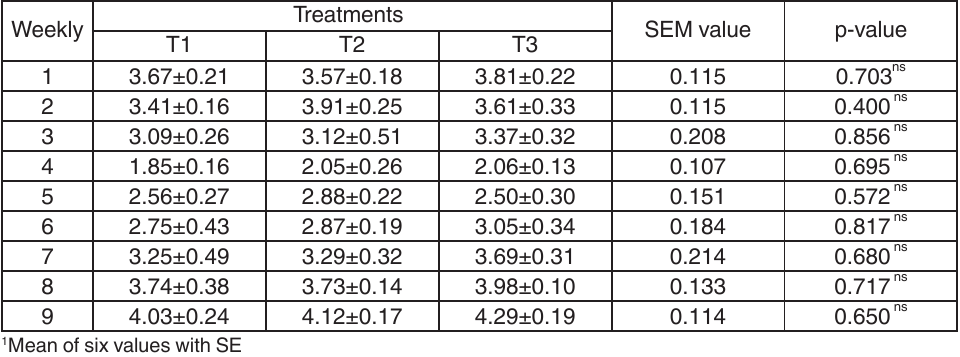
table 2. Weekly average feed intake of sows maintained on the three experimental rations on dry matter basis,